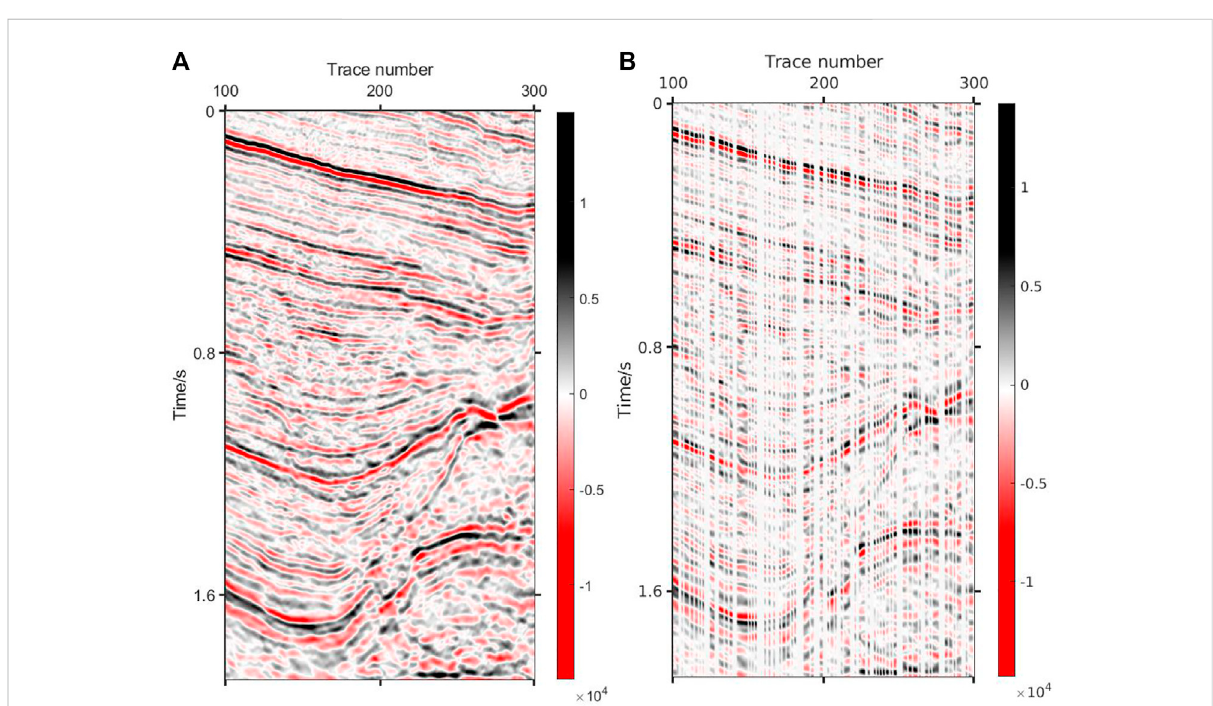
FIGURE 5 Original image and sampled image. (A) Original image; (B) 50% missing data (SNR=3.03 dB PSNR=19.38